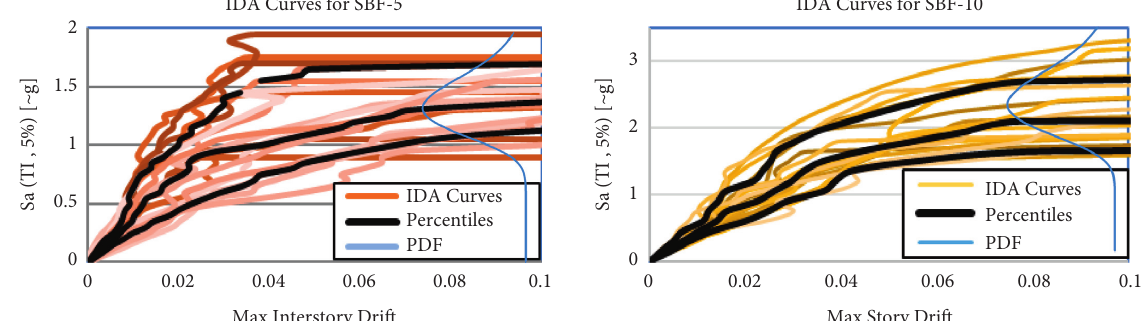
Figure 21: IDA curves obtained from right to left for SBF-10 and SBF-5,